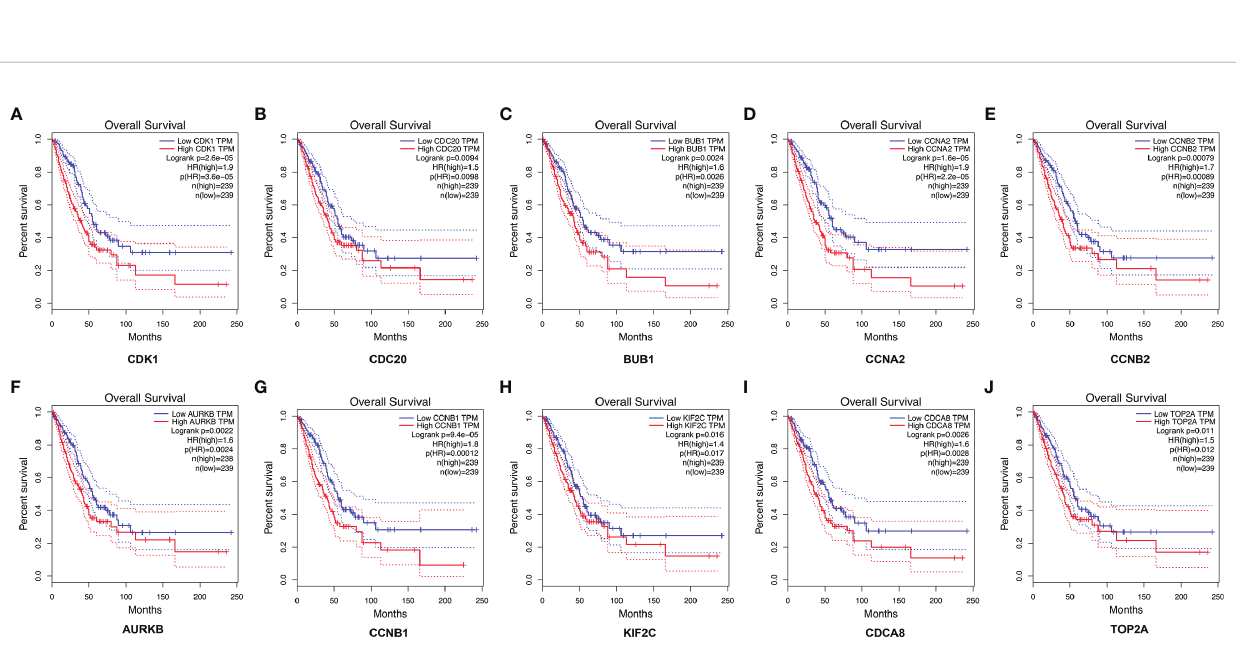
FIGURE 12 | The correlation between the top 10 hub genes and the OS of LUAD patients in the GEPIA database. CDK1 (A) , CDC20 (B) , BUB1 (C) , CCNA2 (D) , CCNB2 (E) , AURKB (F ), CCNB1 (G) , KIF2C (H) , CDCA8 (I) , and TOP2A (J) . LUAD, lung adenocarcinoma.